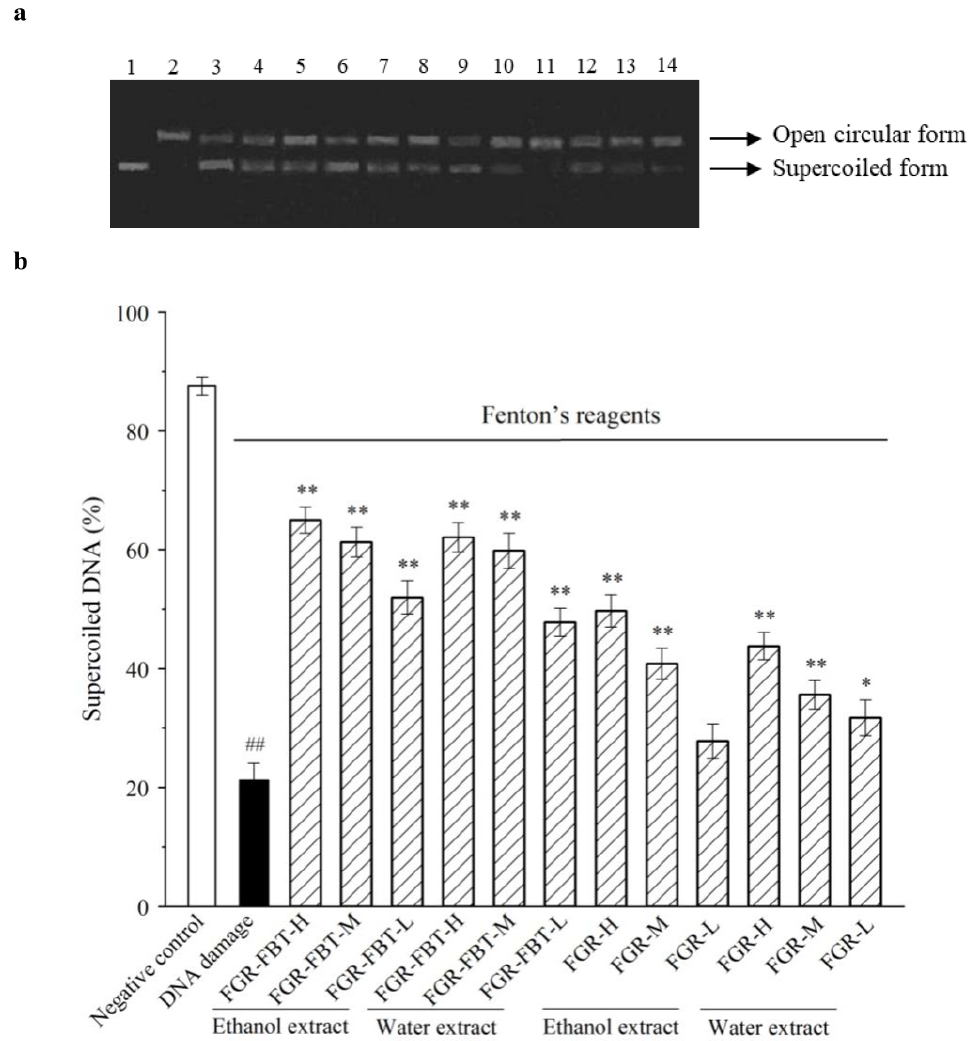
Figure 4. ( a ). DNA oxidative damage-protecting effect of hydroalcoholic extracts (80% ethanol extracts) and water extracts of fermented glutinous rice with Fu brick tea (FGR-FBT) and traditional fermented glutinous rice (FGR) against hydroxyl radical-induced DNA damage of pUC18; ( b ). Protective activities of samples against DNA damage induced by Fenton’s reagent, expressed by the percentage presence of the supercoiled DNA form. Lane 1: native pUC18 plasmid DNA (negative control); lane 2: DNA + Fenton’s reagent (DNA damage control); lane 3-5: DNA + Fenton’s reagent + FGR-FBR hydroalcoholic extract at high, middle, and low concentrations; lane 6-8: DNA + Fenton’s reagent + FGR-FBR water extract at high (H), middle (M), and low (L) concentrations; lane 9-11: DNA + Fenton’s reagent + FGR hydroalcoholic extract at H, M, and L concentrations; lane 12-14: DNA + Fenton’s reagent + FGR water extract at H, M, and L concentrations. The gels were visualized under a UV-transilluminator. H, M, and L concentrations are 400 µ g/mL, 200 µ g/mL, and 100 µ g/mL of samples, respectively. ## indicates significant differences between the negative control and the DNA damage control ( P < 0.01). * indicates significant differences between the samples and the DNA damage control ( P < 0.05). ** indicates significant differences between the samples and the DNA damage control ( P <